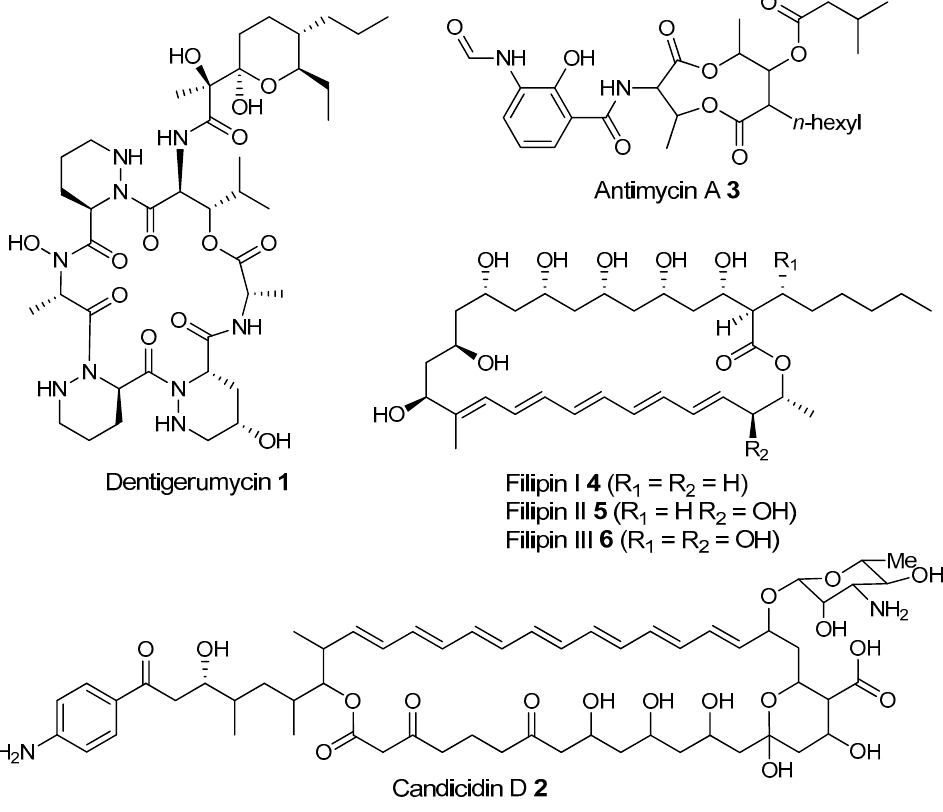
Figure 7. Polyketide and non-ribosomal peptide natural products isolated from bacteria associated with social ants.